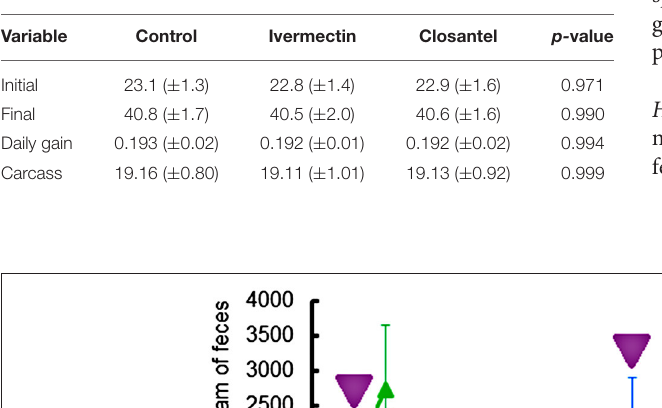
ivermectin and closantel groups.